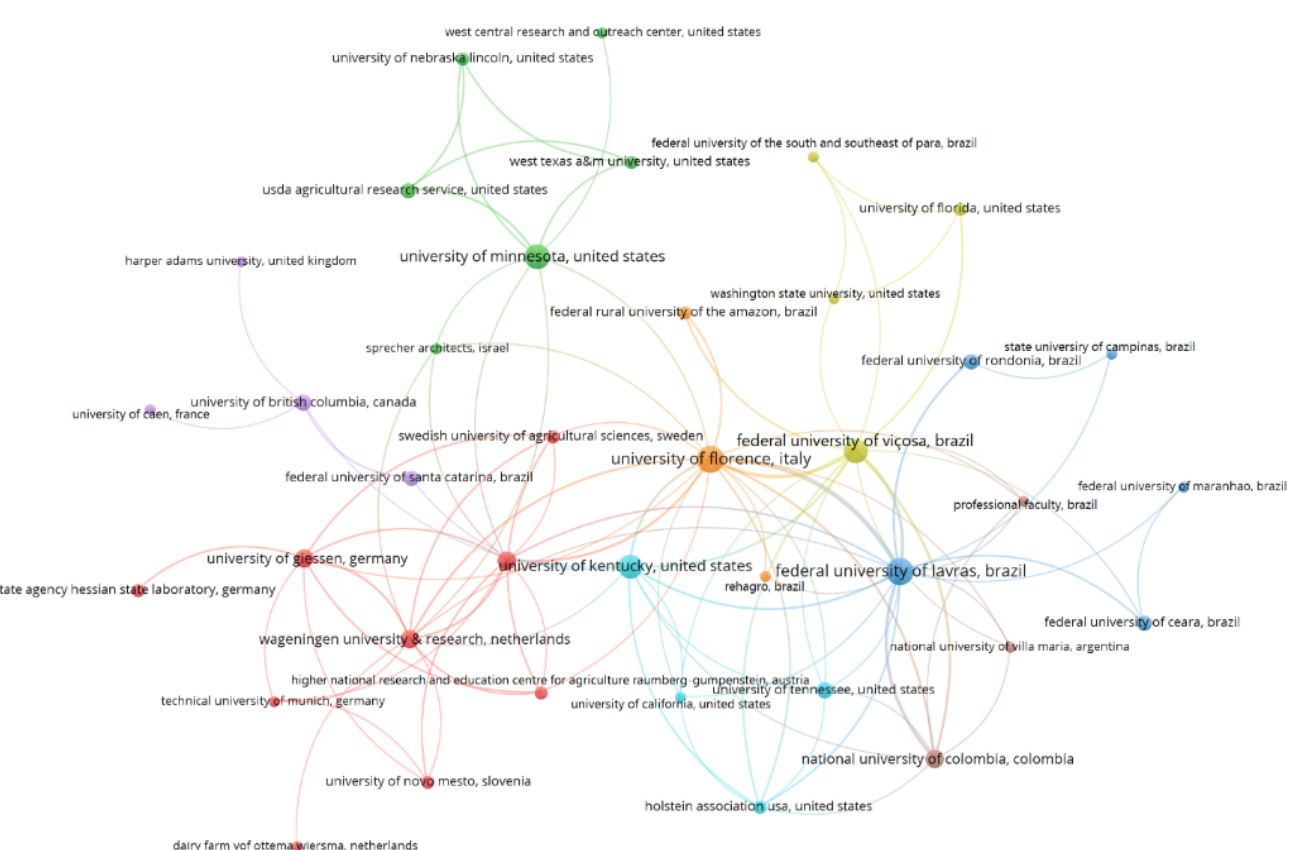
Figure 6. Scientific mapping network of educational and/or research organizations that produce knowledge about compost barns.